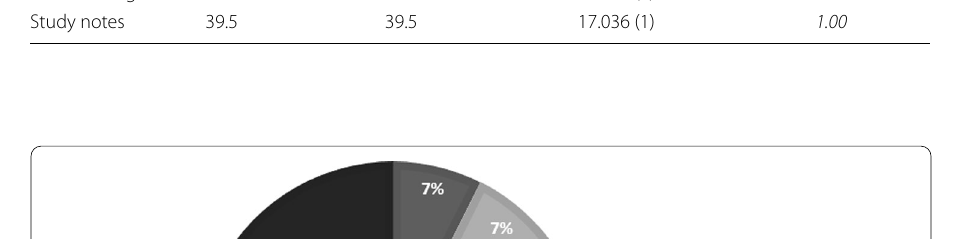
(% using) Test statistics, χ 2 (df) +